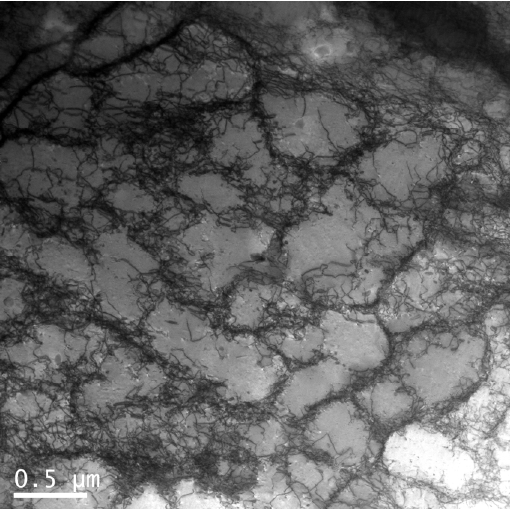
Figure 1. Cell structure in Cu-OFP after 24% cold working. Experimental background in [3].